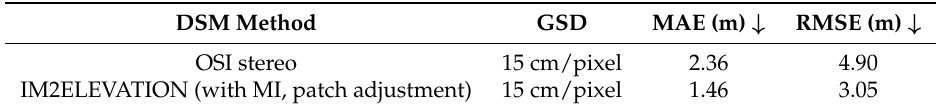
Table 5. Monocular DSM estimation outperforms the stereo imagery-based method. Lower values of MAE and RMSE are